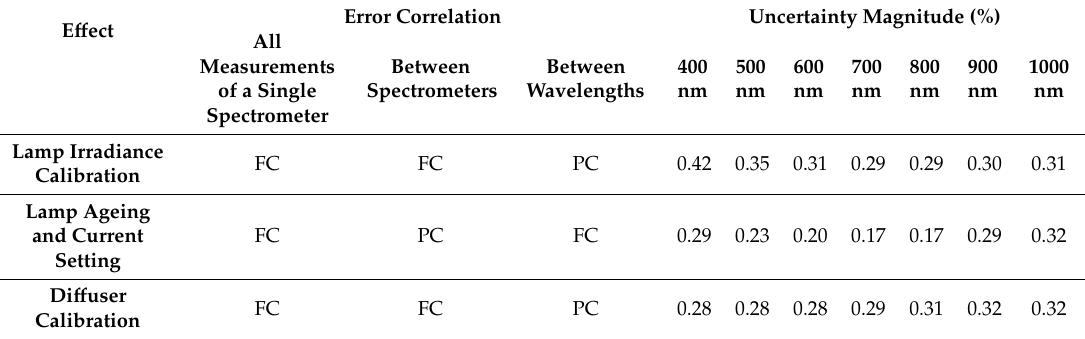
Table A1. Uncertainty budget for BTCN and BSCN BOA reflectance. The abbreviations FC, PC, and I mean fully correlated, partially correlated, and independent, respectively.